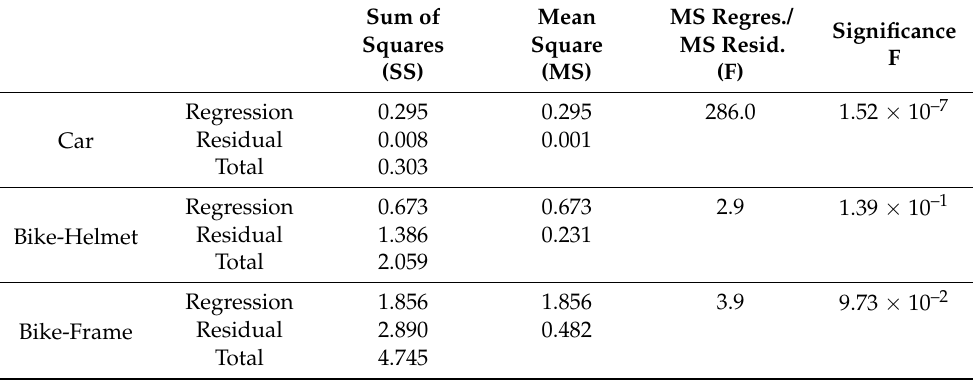
Table 2. Statistical parameters used in evaluating the performance for predicting the PCI- a wz relationship. Sum of